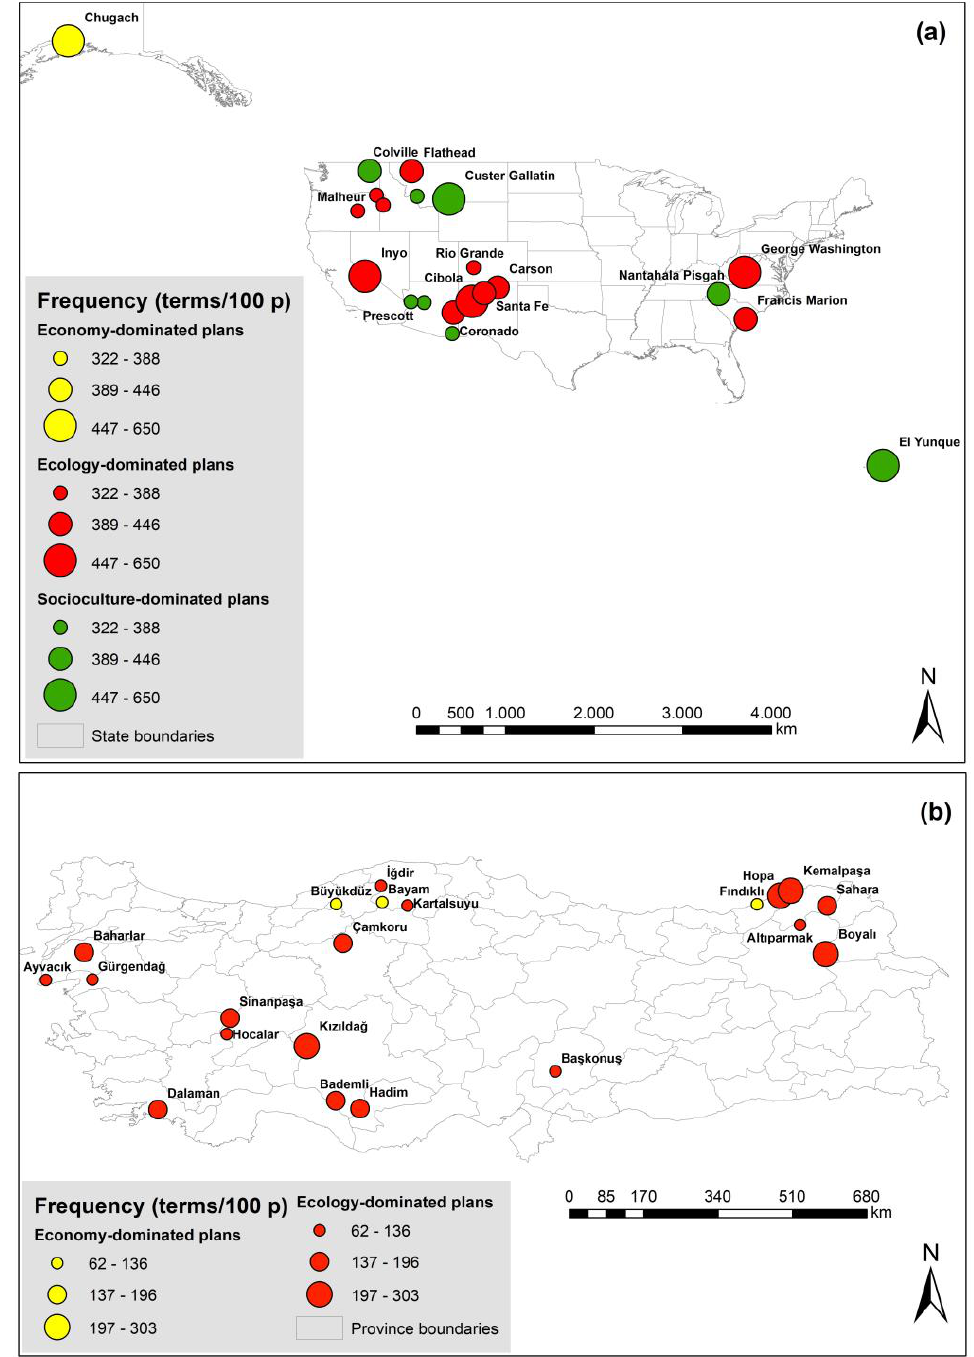
Figure 2. Locations of the US ( a ) and Turkish ( b ) plans with information on term frequency and dominant sustainability aspects.